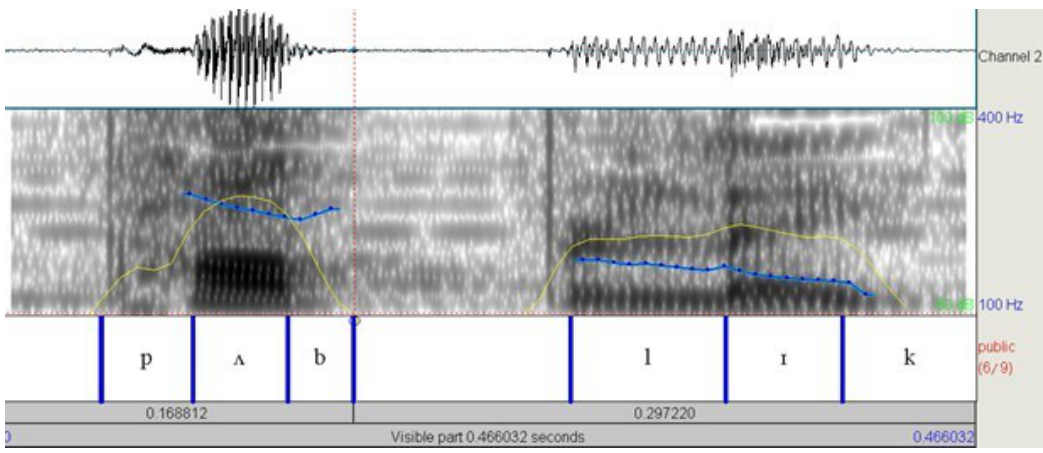
Figure 3 - Falling contour in the utterance produced by a HKE female speaker Note: blue curve indicates F0; yellow curve indicates